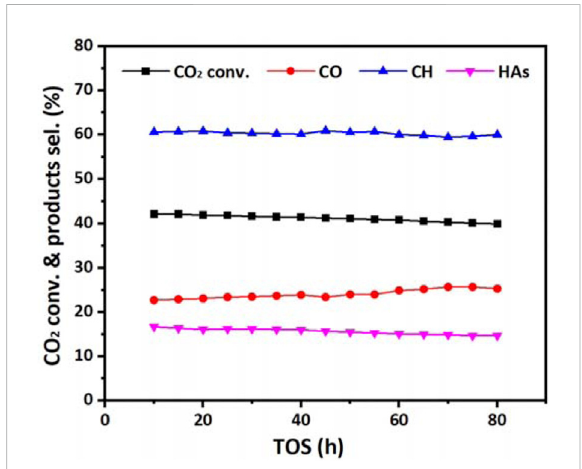
FIGURE 8 CO 2 conversion and product selectivity of MnCuK-FeC/ CuZnAlZr in CO 2 hydrogenation during 80 h reaction. (Reaction Condition: H 2 :CO 2 =3:1, T = 300 ° C, p = 3 MPa, GHSV=6000 ml h − 1 · g cat − 1